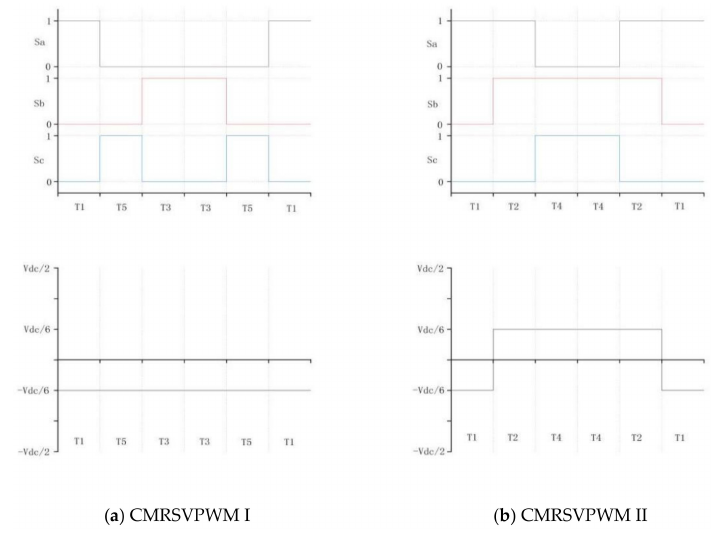
Figure 7. Synthesis of CMRSVPWM and the corresponding